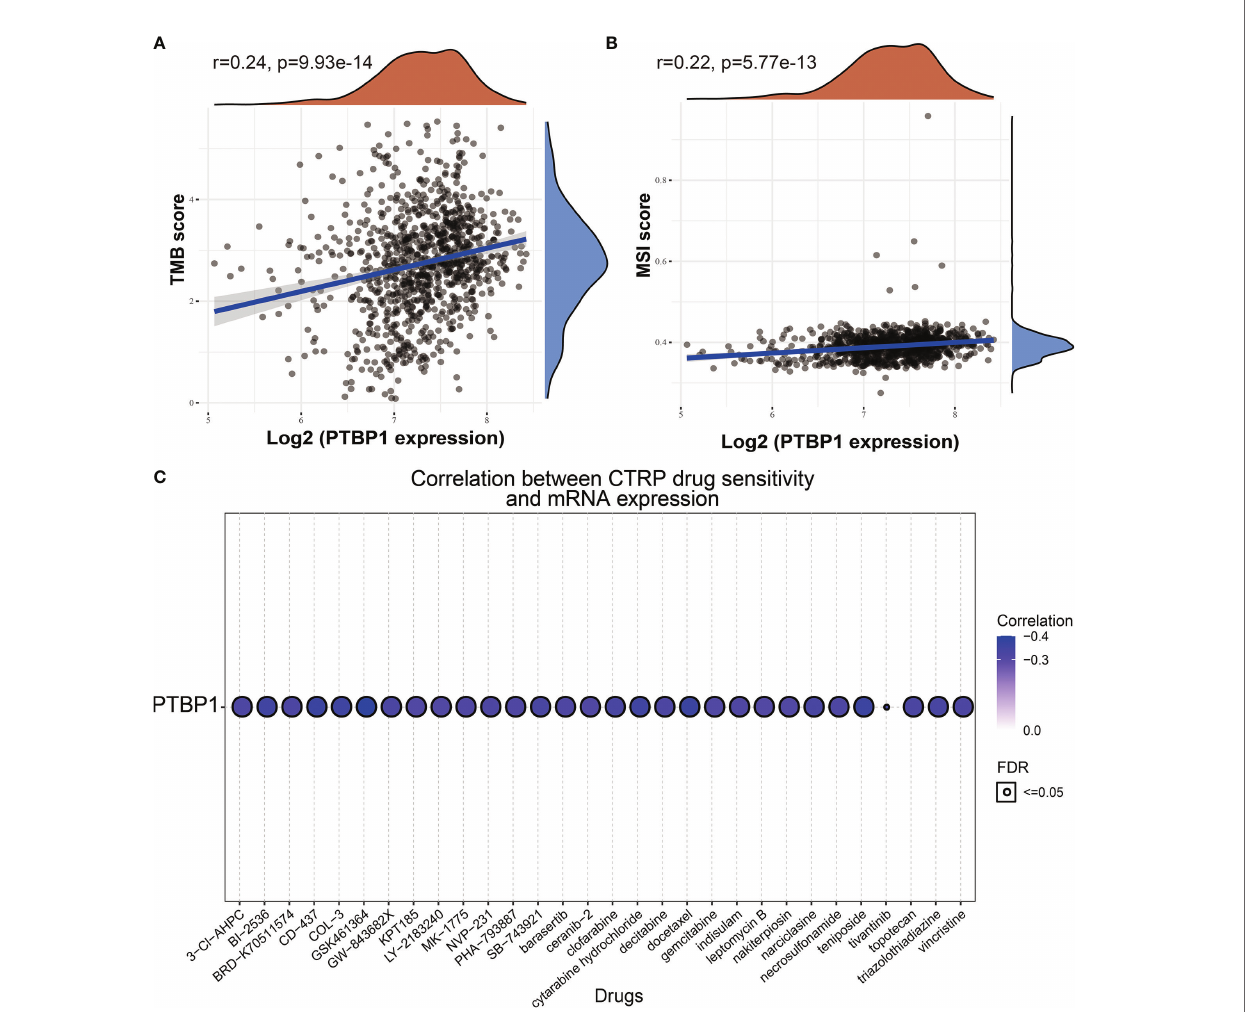
FIGURE 11 | Analysis of the correlation between PTBP1 expression and TMB, MSI and drug sensitivity. (A) The correlation between the PTBP1 expression and TMB in LUAD. (B) The correlation between the PTBP1expression and MSI in LUAD. (C) The correlation between the PTBP1 expression and drug